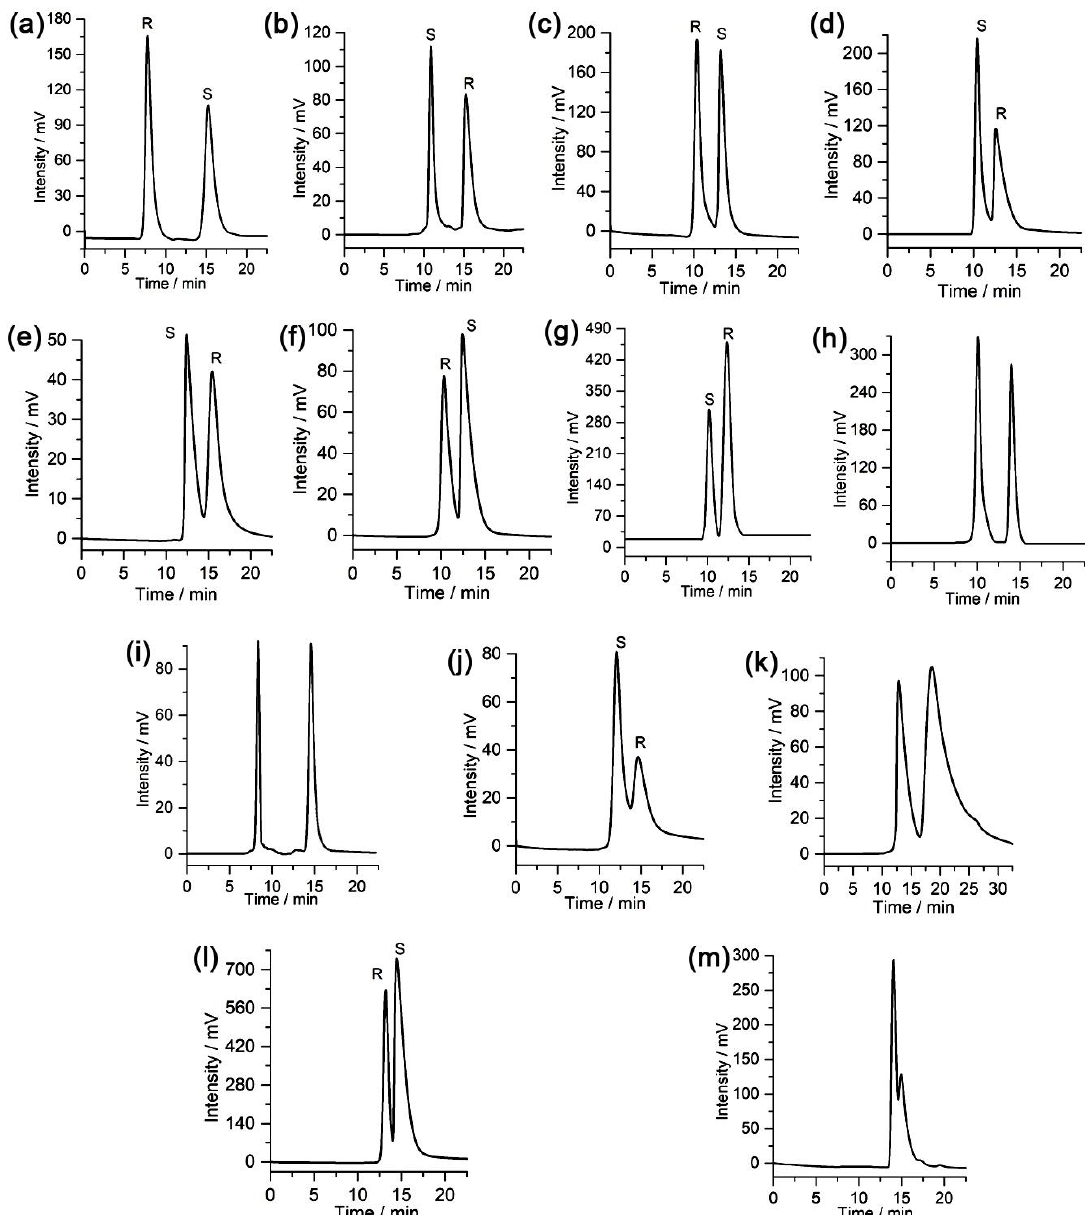
Figure 3. Chromatograms obtained for the separation of racemates on the chiral POC-based CSP packed column: ( a ) 1-(1-Naphthyl)ethanol, ( b ) 3-benzyloxy-1,2-propanediol, ( c ) 2-phenyl-1-propanol, ( d ) trans -1,2-diphenylethylene oxide, ( e ) benzoin, ( f ) 1-phenyl-1-propanol, ( g ) hydrobenzoin, ( h ) 1-phenylethylamine, ( i ) ofloxacin, ( j ) mandelic acid, ( k ) naproxen, ( l ) 1-(4-chlorophenyl)ethanol, and ( m ) 1-(3-methylphenyl)ethanol.